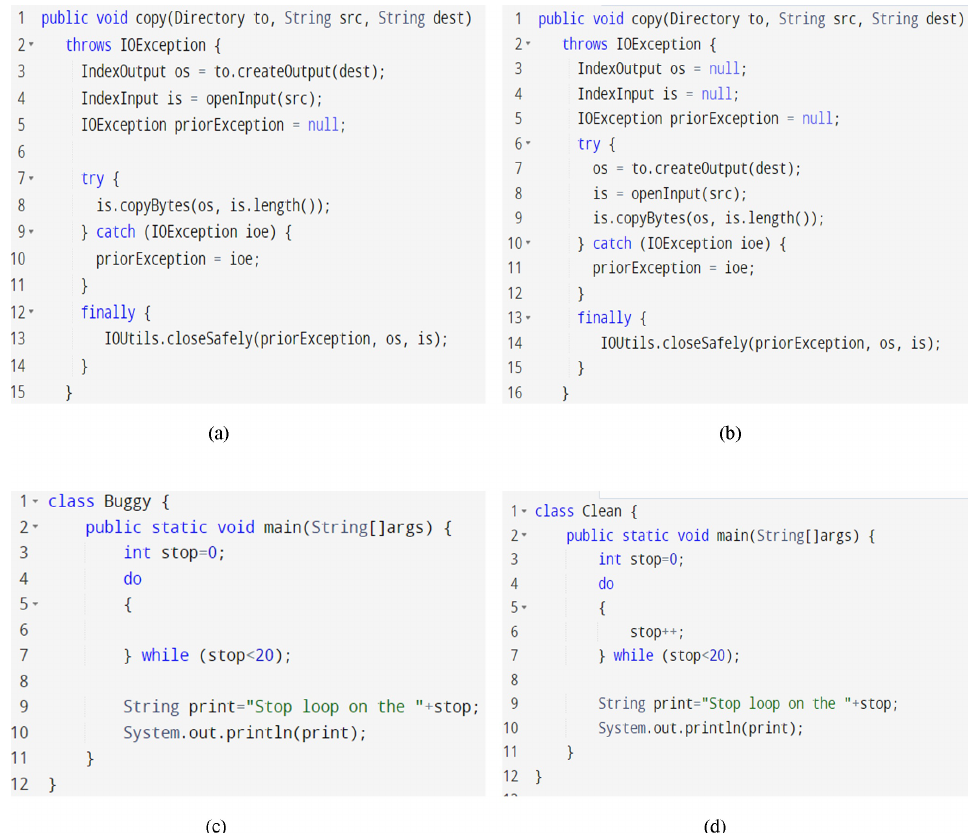
Figure 7. Motivating Java code example. ( a ) Original buggy code (memory leak bug), ( b ) Code after fixing the memory leak bug, ( c ) Original buggy code (infinite loop bug), and ( d ) Code after fixing the infinite loop